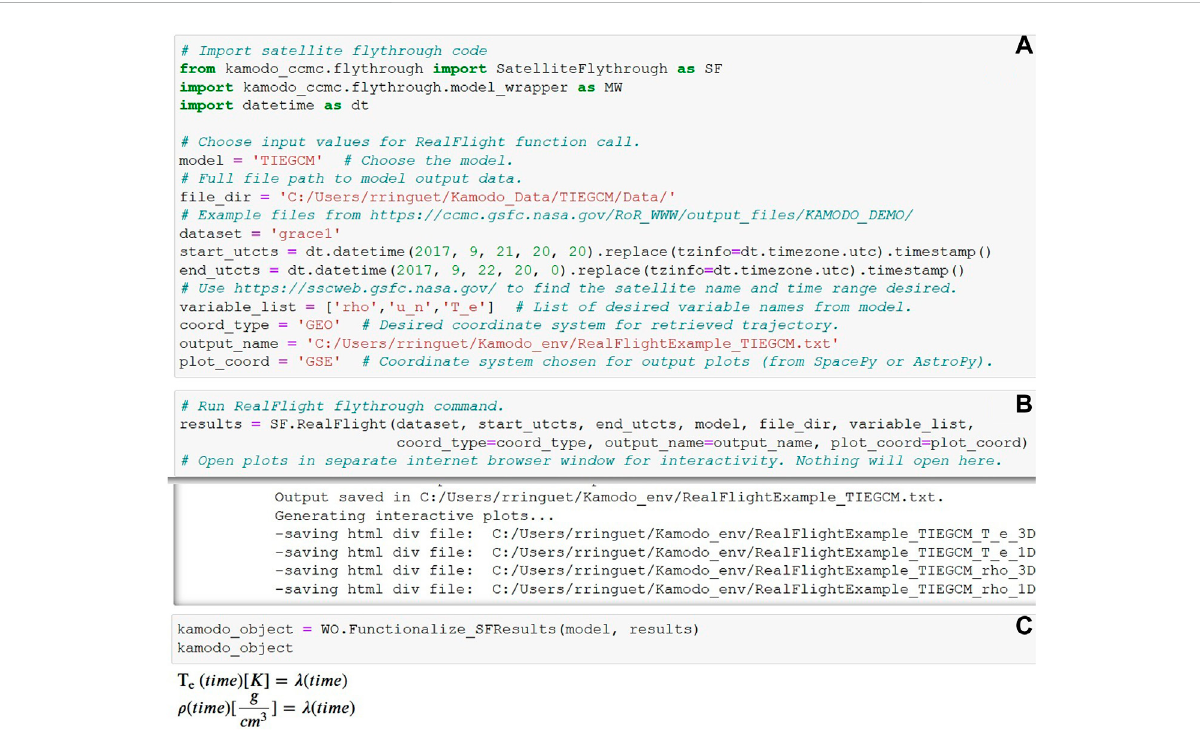
FIGURE 4 Example notebook demonstrating the model-agnostic syntax of the RealFlight fl ythrough function. The fi rst block (A) shows the two required import statements and chosen variable values. The datetime package is imported to deal with the generation of the UTC timestamps. The second block (B) presents the model-agnostic syntax of the function call, and the last block (C) shows a simple way to functionalize the Python object returned by the fl ythrough